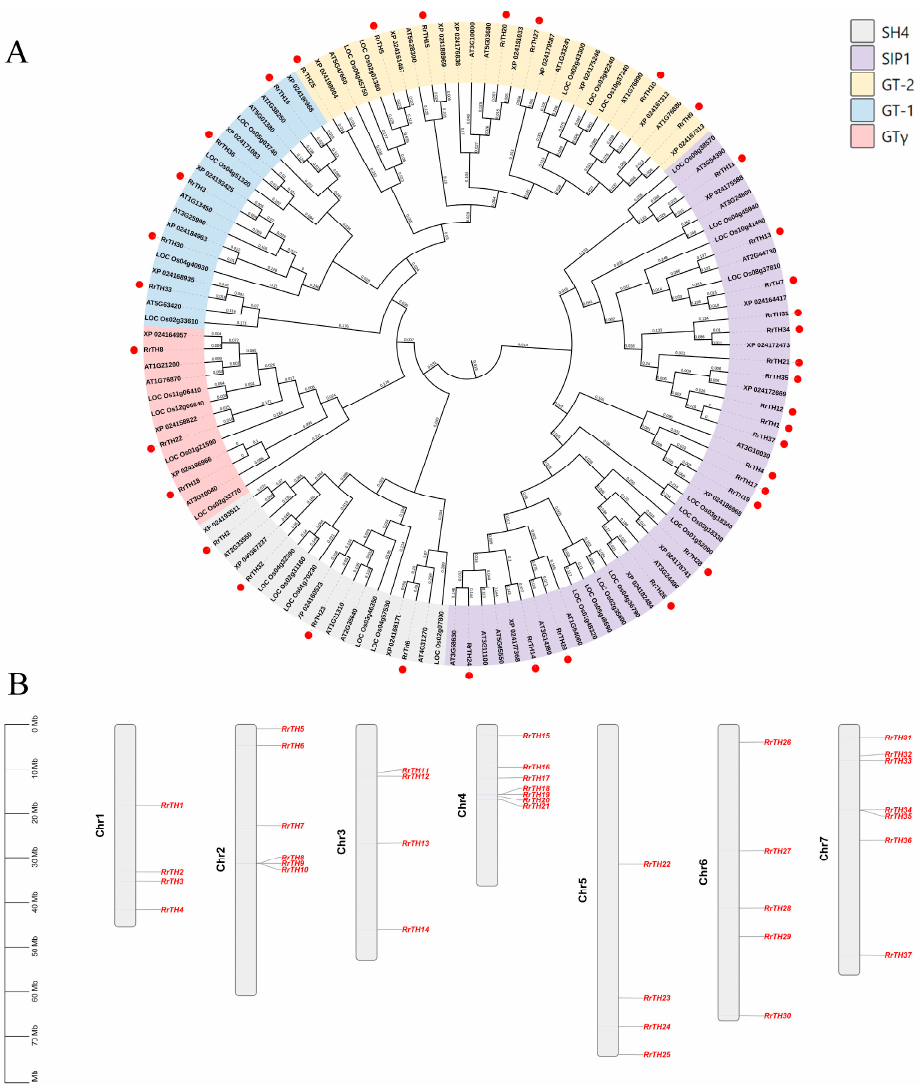
Figure 1. The phylogeny ( A ) and chromosome location ( B ) of GT family of Rosa rugosa ( RrGT ). The dendrogram of GTs of R. rugosa , Rosa chinensis (XP), Oryza sativa (LOC) and Arabidopsis thaliana (AT) was generated using the neighbor-joining method with 1000 bootstrap replicates (numbers in branches). Nodes were colored according to the five lineages of GT family and RrGTs were highlighted by red dots. The gene ID was listed in Table